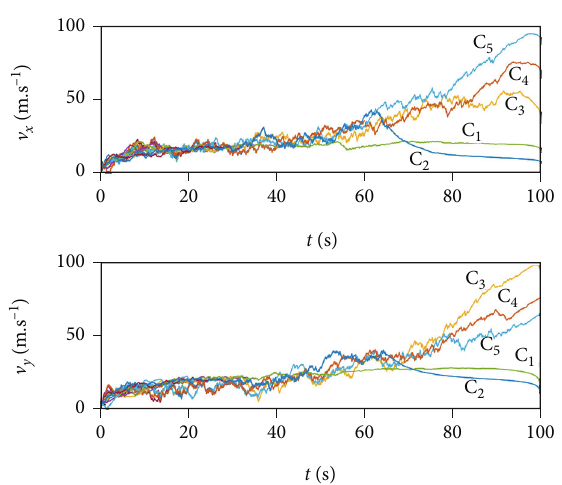
Figure 8: Cluster motion speed of the above scenario.